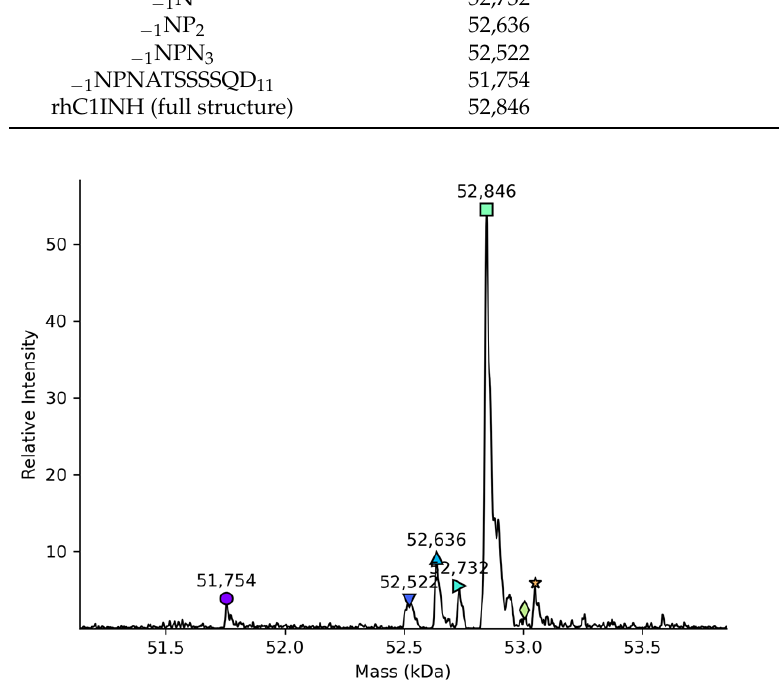
Table 1. The LC-MS data on the mass of the deglycosylated rhC1INH. PTM Mass, Da Amount, %